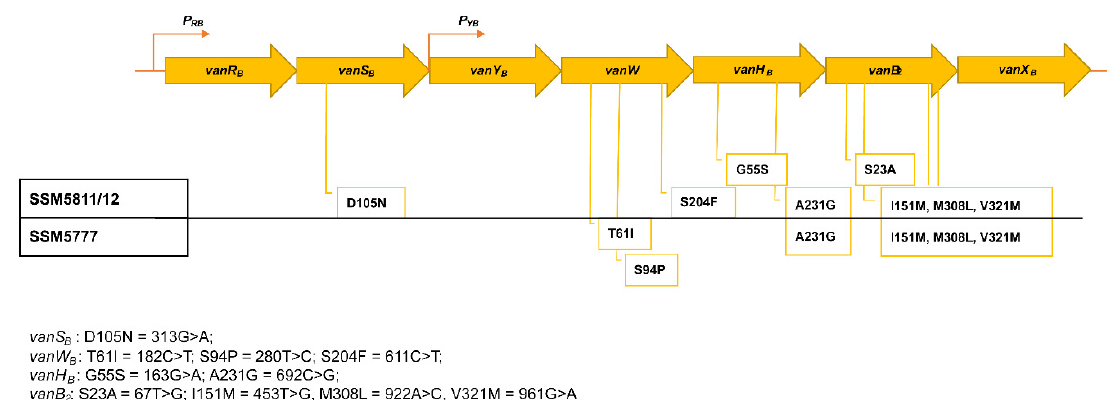
Figure 1. Schematic representation of vanB 2 operon in VREfm and in occult isolate, with the amino acid substitutions framed and in line with the corresponding regulation and resistance genes. For each van gene, the amino acid replacements (D = Asp, N = Asn, T = Thr, I = Ile, S = Ser, P = Pro, F = Phe, G = Gly, A = Ala, M = Met, L = Leu, and V = Val) corresponding to nucleotide mutations are shown below on the left.